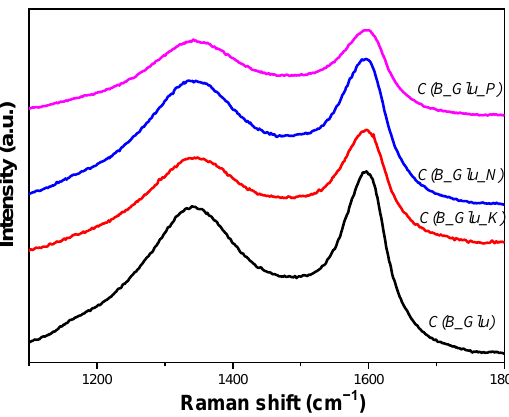
Figure 9. Raman spectra for the synthetized carbons. Table 4. D/G intensity ratios for the obtained carbons.